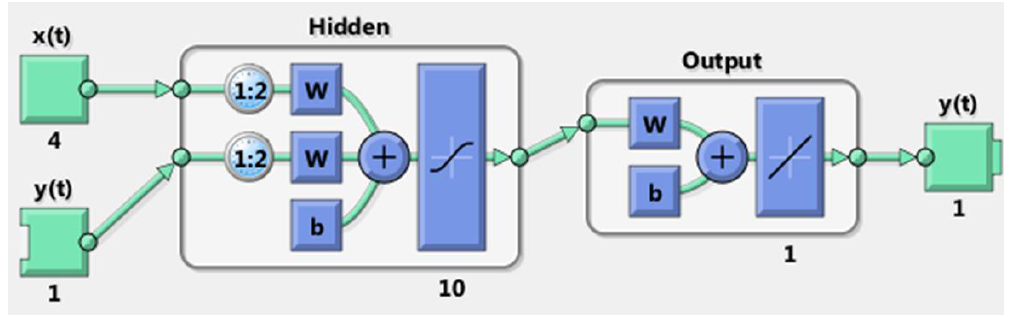
Figure 12. NARX generated in the MATLAB